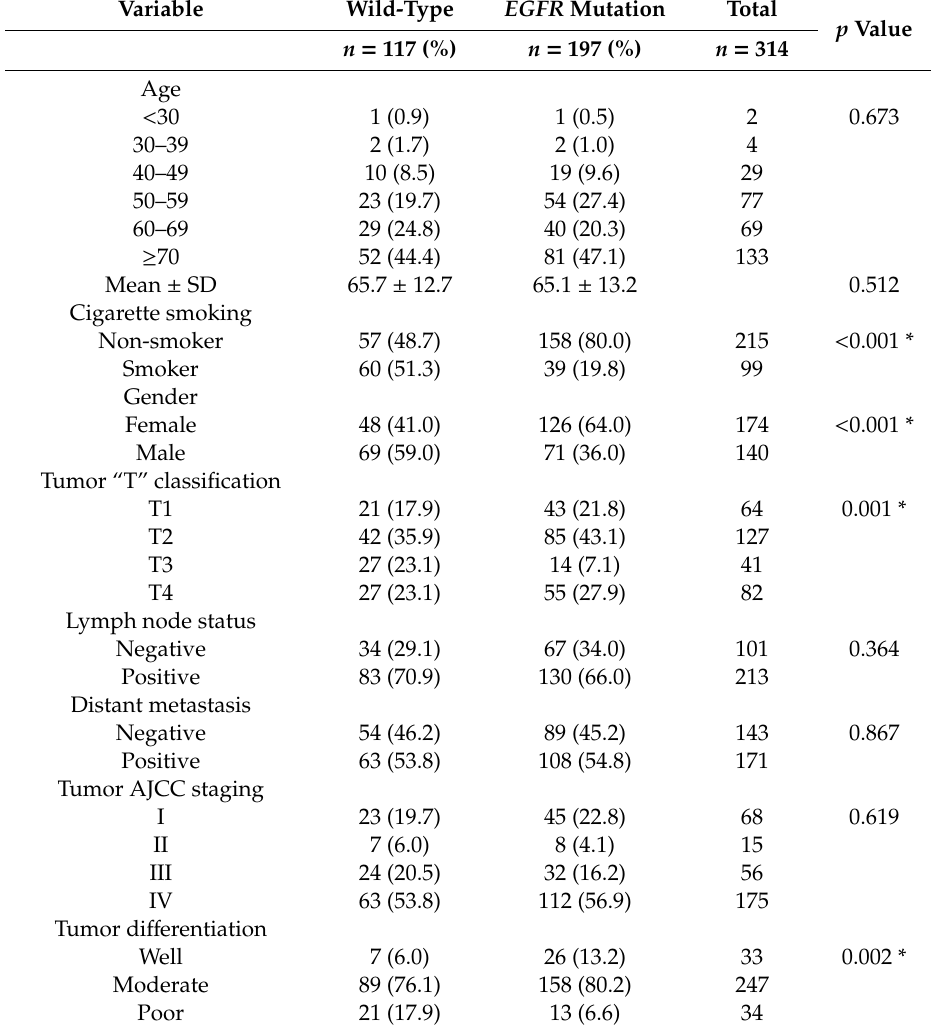
Table 1. Distributions of demographical characteristics in 314 patients with lung adenocarcinoma by EGFR mutation